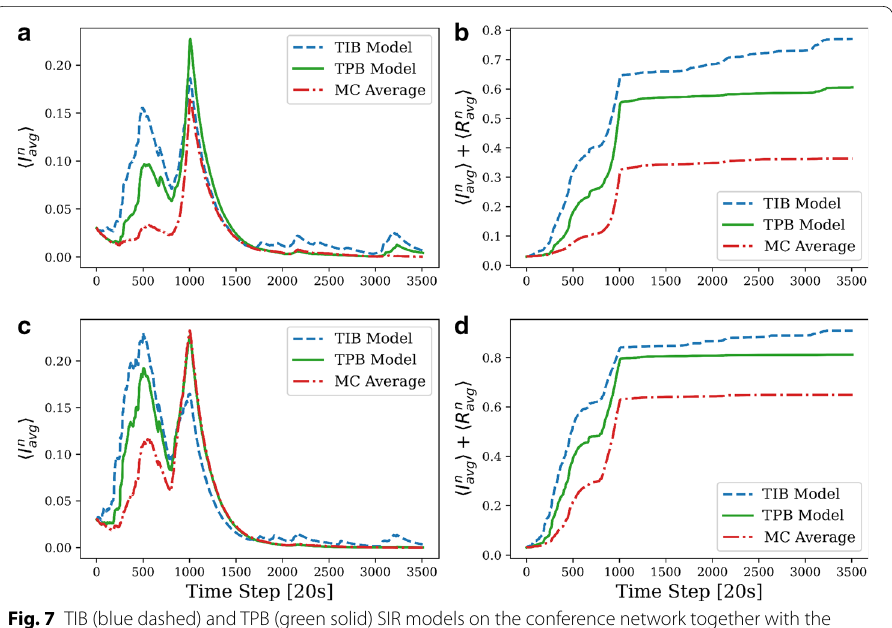
Fig. 7 TIB (blue dashed) and TPB (green solid) SIR models on the conference network together with the average of 10 3 Monte-Carlo (MC) simulations (red dash-dotted). a , c The time series for the prevalence of infection in the network. b , d Depict the cumulative prevalence of infection within the network. The probability of infection is set to β = 0.3 in a , b and β = 0.5 in c , d . The initial chance of infection is 0.03. Other parameters: µ = 0.005